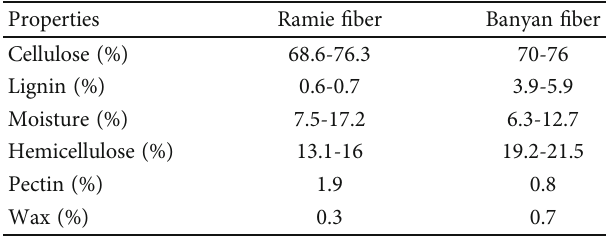
Table 2: Chemical properties of banyan and ramie fi bers [17].